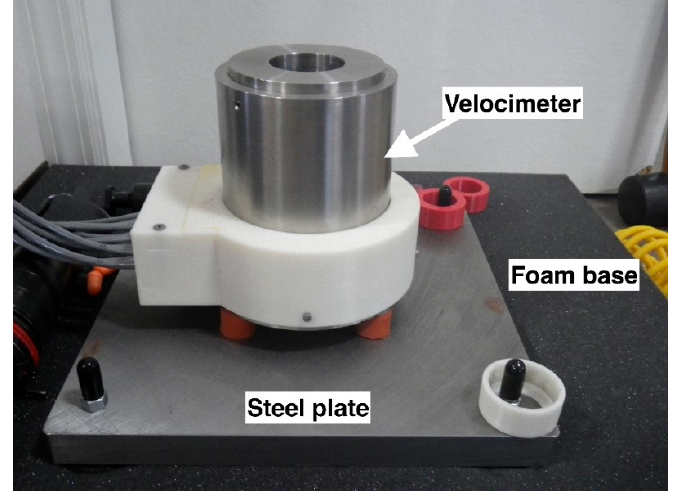
Figure 5. Velocimeter apparatus setup for firing.